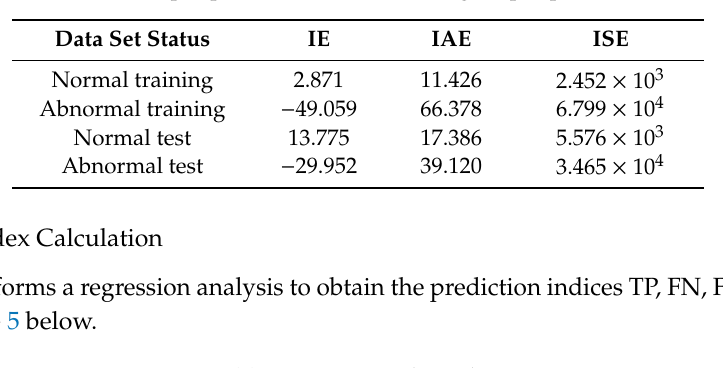
Table 4. Actual output power and model training output power error index.